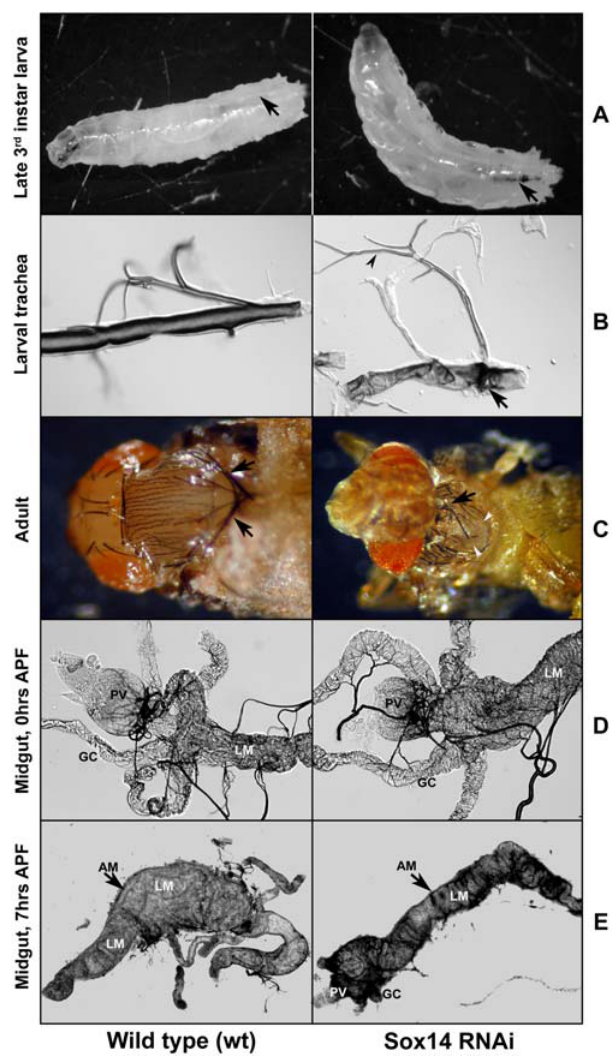
Figure 6. Sox14-RNAi animals have multiple developmental abnormalities including defects in larval midgut destruction. Control wt late 3rd instar larva show normal trachea (left, arrow) but Sox14-RNAi late 3rd instar larva displayed tracheal defects detectable as blackened regions (right, arrow). (B) Dorsal tracheal trunks of Sox14- RNAi animals (right) showed severely distorted taenidial folds, collapse of the tracheal cuticle and blackening of the cuticle (arrow). Branching of the trachea in Sox14-RNAi animals appears to occur normally (arrowhead) as in control wt animals (left). (C) Sox14-RNAi pharate adults dissected from the pupal case showed defects in eyes, notum, and bristles (right, arrow). A control wt pharate adult with normal eyes, notum and bristles (arrows) is shown on the left for comparison. (D) In the 0 hr APF larval midgut (LM) from both control wt (left) and Sox14- RNAi animals (right), the proventriculus (PV) and gastric caecae (GC) are evident. (E) In wt animals, the midgut condensed by 4 hrs APF (not shown) and the gastric caecae were not detectable by 7 hrs APF. Condensed wild type larval midgut (LM) was found within the adult midgut by 7–12 hrs APF (left). Sox14-RNAi animals showed some condensation of the midgut but the proventriculus (PV) and remnants of gastric caecae (GC) can still be observed even after 7–12 hrs APF (right). In both wt and Sox14-RNAi animals, a layer of adult midgut (AM, arrow) can be observed after 4 hrs